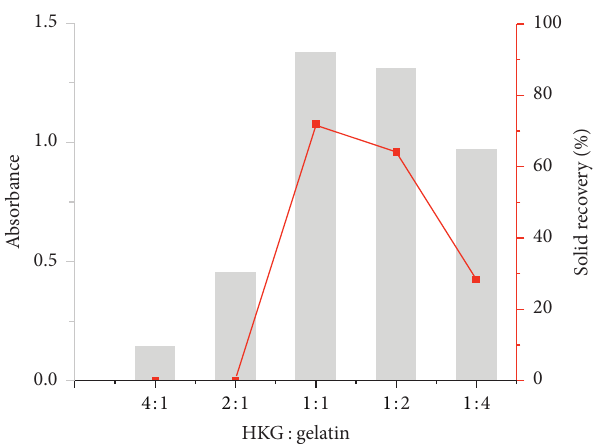
Figure 3: Maximum absorbance and solid recovery from the dispersions with different HKG:gelatin ratios. Figure 2: Turbidity of the complex coacervate dispersions at